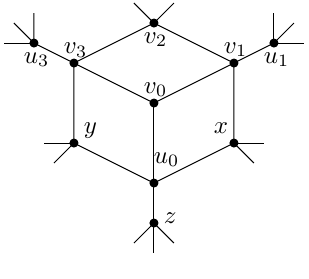
Fig. 4: The symmetric neighborhood of vertex v 0